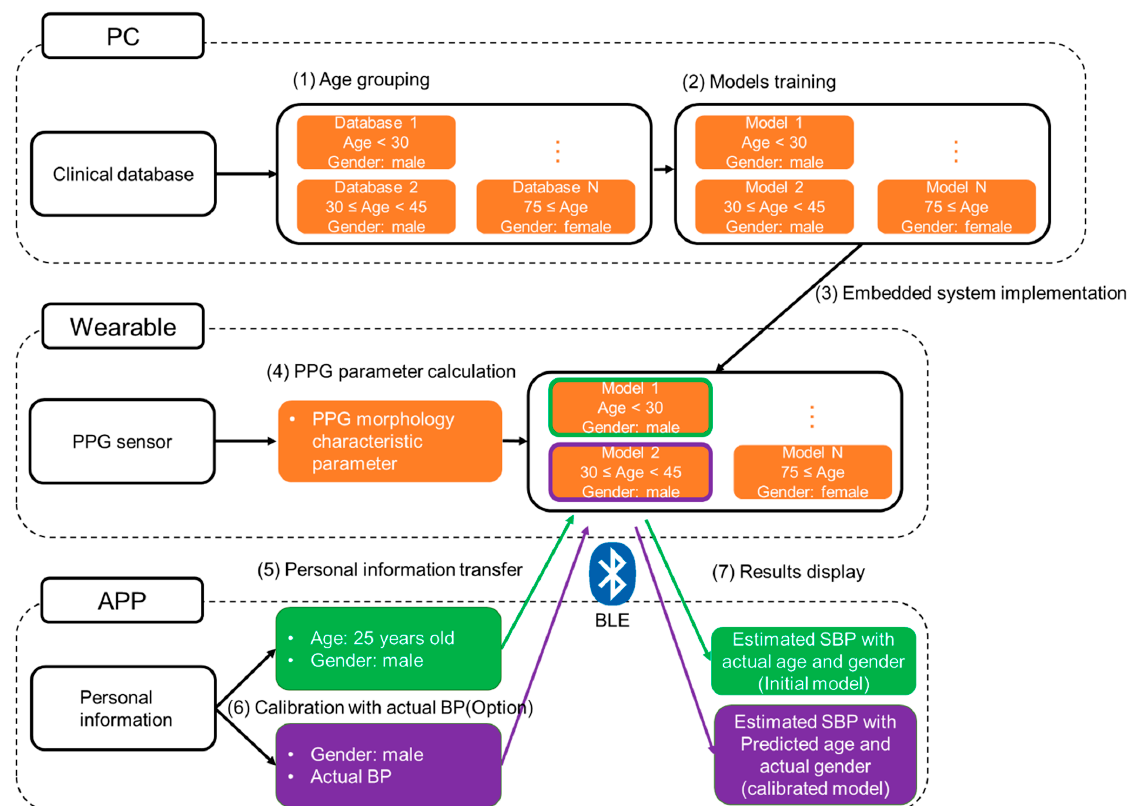
Figure 6. The details of the block diagram of the calibration were divided into seven steps (i.e., (1) Age grouping; (2) Models training; (3) Embedded system implementation; (4) PPG parameter calculation; (5) Personal information transfer; (6) Calibration with actual BP; (7) Results display.).